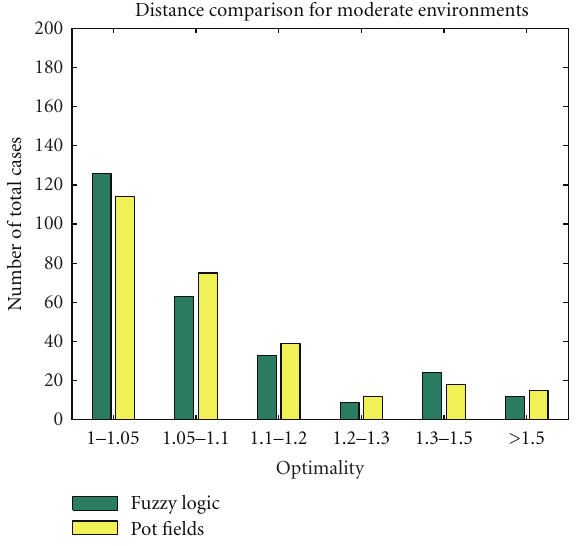
Figure 19: Extra distance traversed for the approximate solutions in complex (very dense)